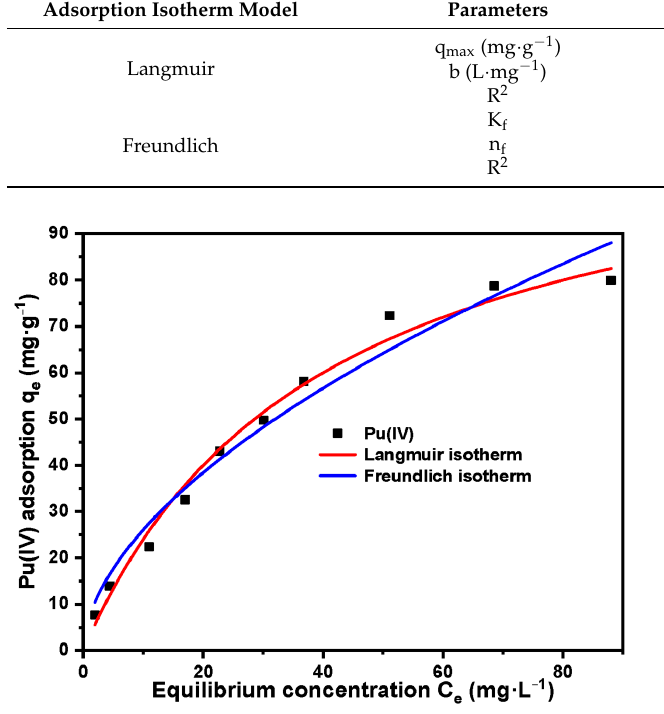
Figure 18. Adsorption isotherm model for Pu(IV) on SG-VTS-VPQ. Table 5. Langmuir and Freundlich adsorption isotherm parameters for Pu(IV) on SG-VTS-VPQ. Van’t Hoff’s fitting results and parameters for temperature changes are shown in